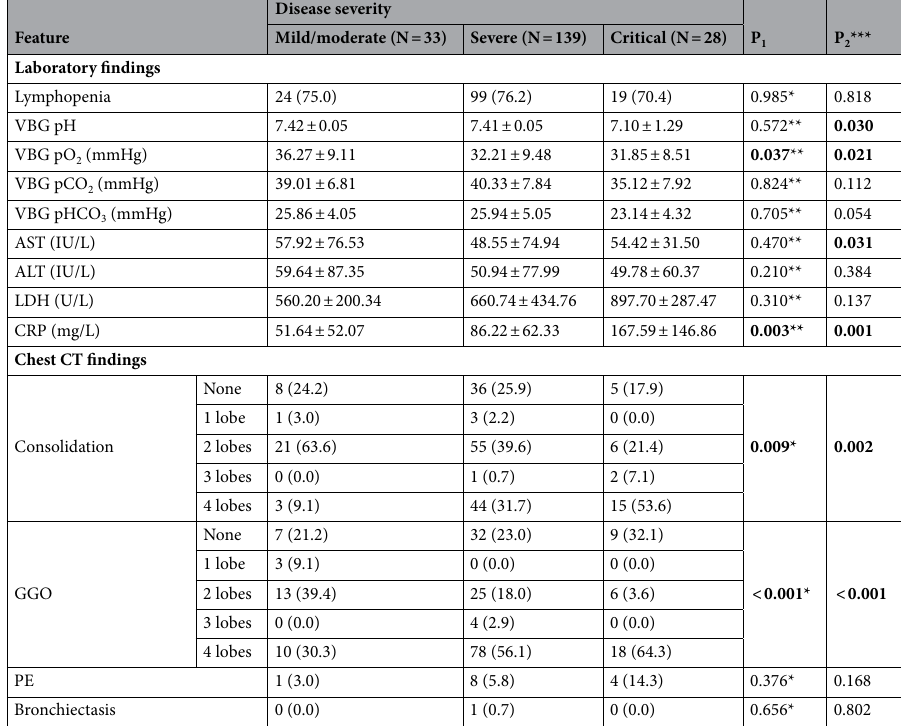
Table 3. Paraclinical data in patients with different disease severities. VBG venous blood gas, AST aspartate aminotransferase, ALT alanine aminotransferase, LDH lactate dehydrogenase, CRP C-reactive protein, CT computed tomography, GGO ground-glass opacity, PE pleural effusion. P 1 : Comparison between mild/ moderate and severe/critical groups. P 2 : Comparison between mild/moderate, severe, and critical groups. Bold values are statistically significant (P < 0.05). *Chi-square or Fisher’s exact test. **Mann–Whitney test. ***Kruskal–Wallis test.